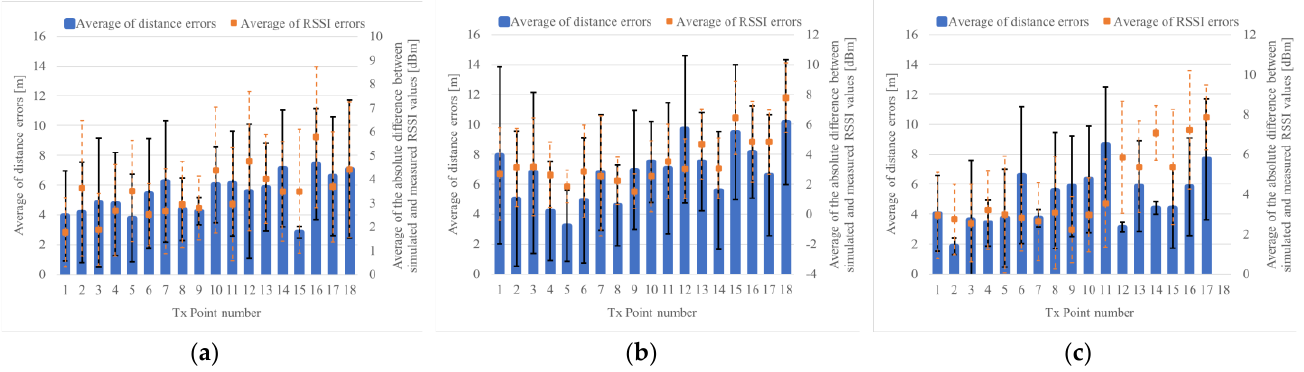
Figure 15. Position estimation results of actual measurement in T-shape road. ( a ) Rx moves to the left side, ( b ) Rx moves to the middle, ( c ) Rx moves to the right side.